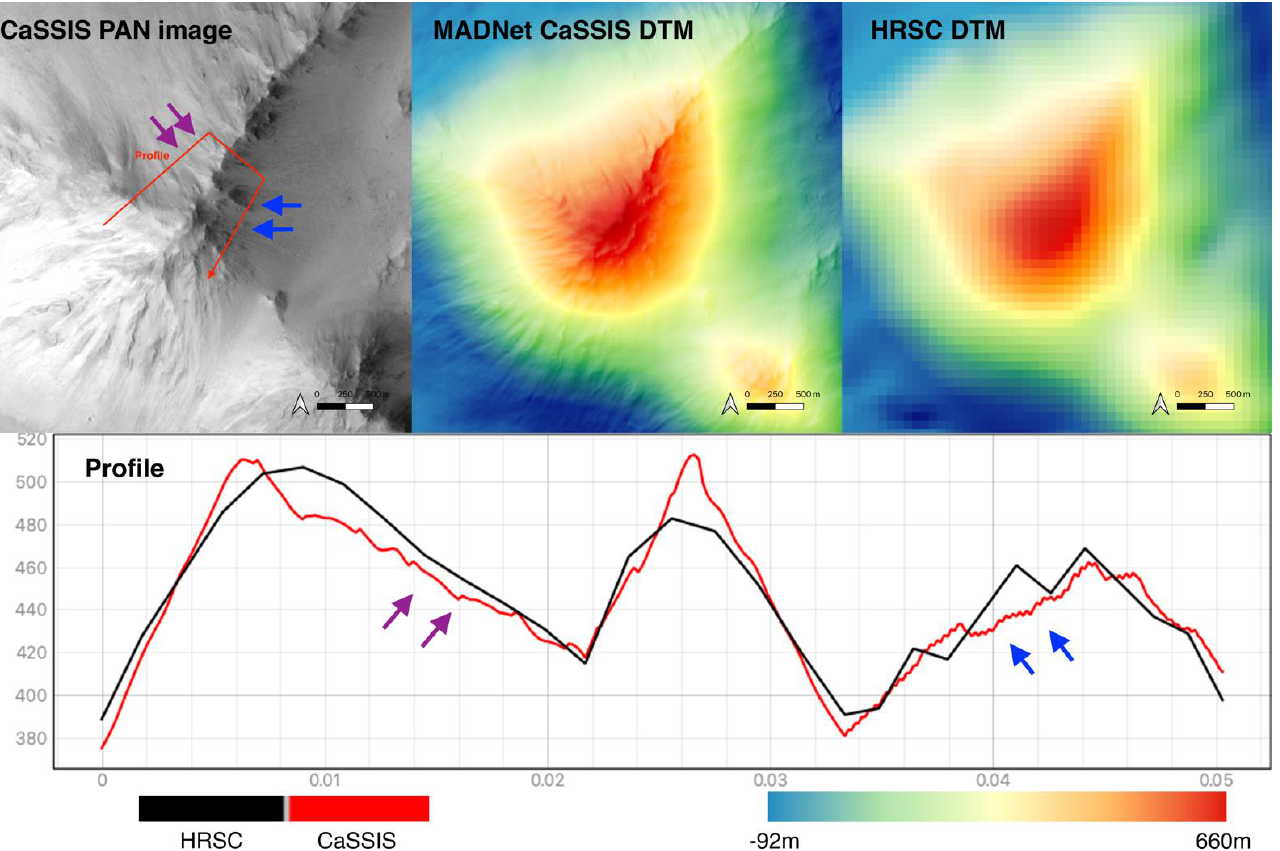
Figure 14. CaSSIS panchromatic band image (MY34_005367_181_1), 8 m/pixel MADNet CaSSIS DTM, the corresponding 50 m/pixel HRSC DTM (h1059_0000_da4), and the measured profile line (location is shown on the CaSSIS image) demon- strating an “over-smoothing” issue for capturing fine-scale features on steep slopes. All DTMs are colour hillshaded. To look into details—please refer to the full-resolution figures provided in Supplementary Materials.